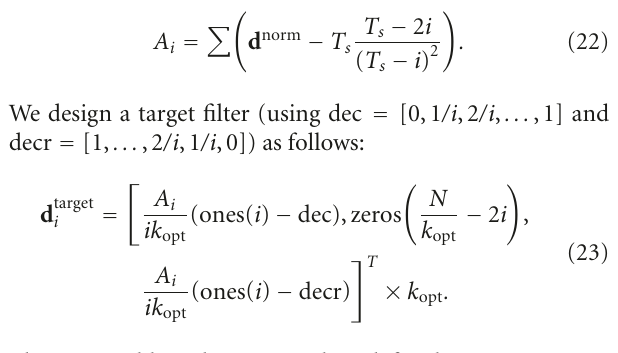
Table 2: OFDM signal